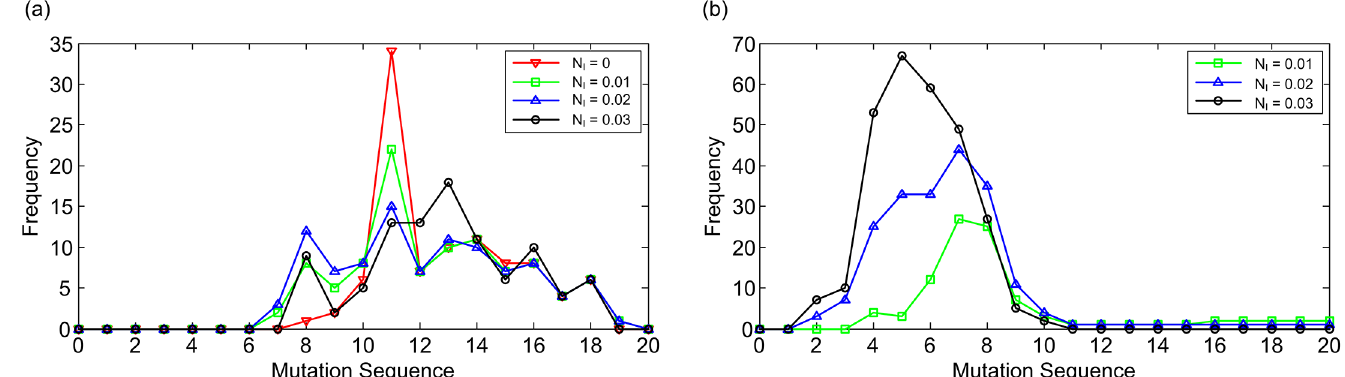
Fig 3. Generality of the more frequent flickering state transition before developing into colorectal cancer. Colorectal tumorigenesis is driven by the sequential accumulation of 20 gene mutations for 100 representative sequences for 20 gene mutations that drive colorectal tumorigenesis (S1 Table). Zero on the x-axis means no mutation. (a) The frequency distribution of the occurrence point of the cancerous state along with the sequences that drove the cancerous state for the various levels of noise intensity. For the noise intensities of 0, 0.01, 0.02, and 0.03, the cancerous state occurs in 97, 99, 99, and 97 sequences of the 100 sequences, respectively (Table 1). (b) The frequency distribution of the M F greater than the M FTH at every mutation occurrence along with the sequences that drove the cancerous state for the various levels of noise intensity. We defined the upper threshold of M F (M FTH ) to investigate whether the flickering state transition becomes more frequent in the attractor landscape. For the noise intensities of 0.01, 0.02, and 0.03, an M F greater than the M FTH appears in 46, 80, and 81 sequences of 99, 99, and 97 sequences that drove the cancerous state, respectively (Table 1). The y-axis indicates how many sequences among the sequences that drove the cancerous state have an M F greater than the M FTH at a particular mutation occurrence.